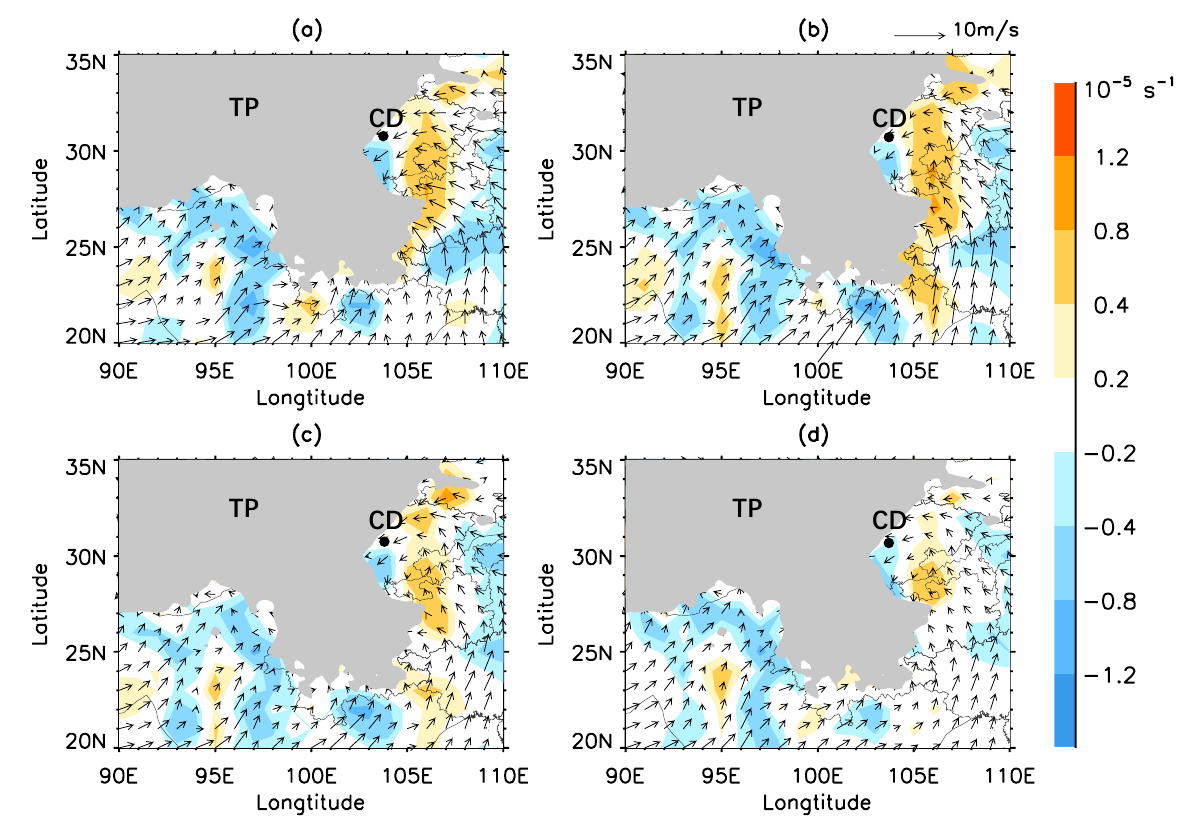
Figure 11. 850 hPa averaged horizontal winds (vector) and relative vorticity (shaded, s − 1 ) for the four moments (2000 BJT, 0200 BJT, 0800 BJT, and 1400 BJT) during 2018 – 2020. ( a – d ) for 2000 BJT, 0200 BJT, 0800 BJT, and 1400 BJT, respectively. TP and CD denote the Tibetan Plateau and Chengdu, respectively.